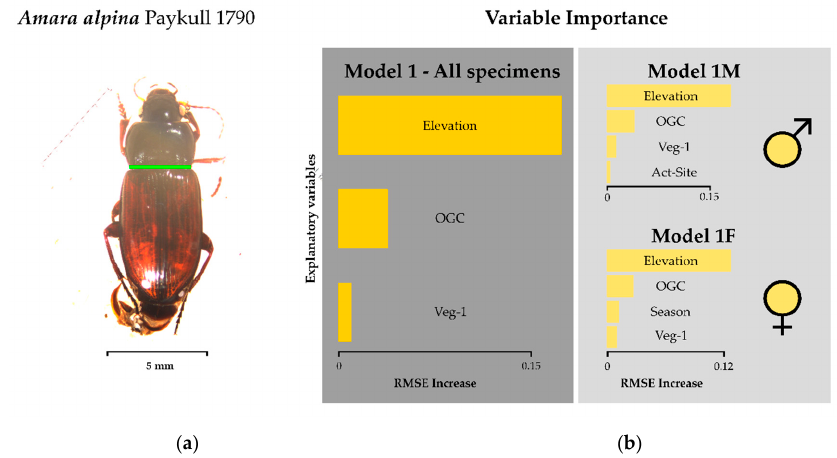
Figure 2. Model results for pronotum width: ( a ) green bar on photograph indicates location of measurement, ( b ) variable importance determined by RMSE increase of model permutations) of the ground beetle Amara alpina . See Table 2 for model formulation and Table 1 for a detailed description of model parameters. Variables used here are Elevation, OGC = open ground cover, Veg-1 = number of plant species, Act-Site = activity–abundance of A. alpina per site. Results are given for all specimens (dark grey field) and based on sex (light grey